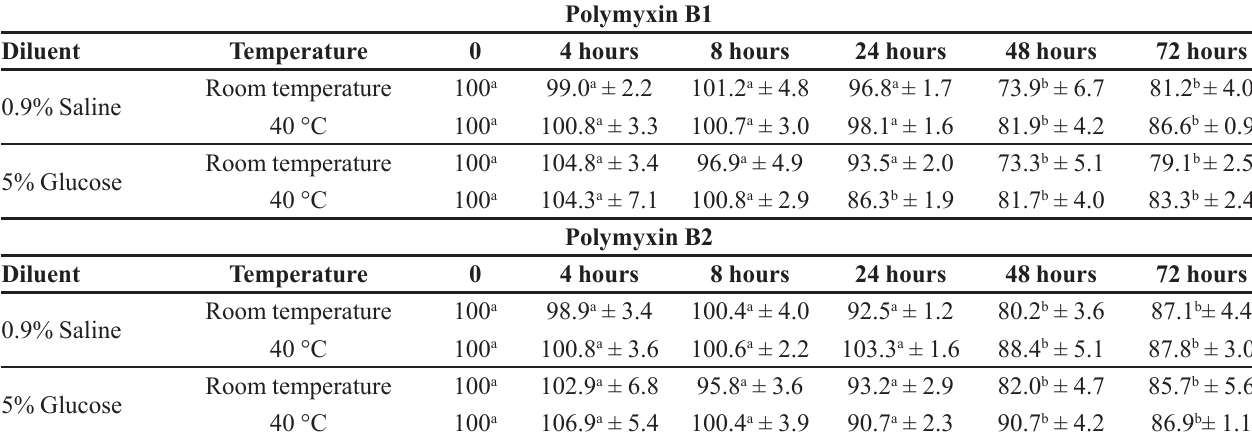
TABLE II ‑ Percentage of Polymyxin B1 and B2 during the stability